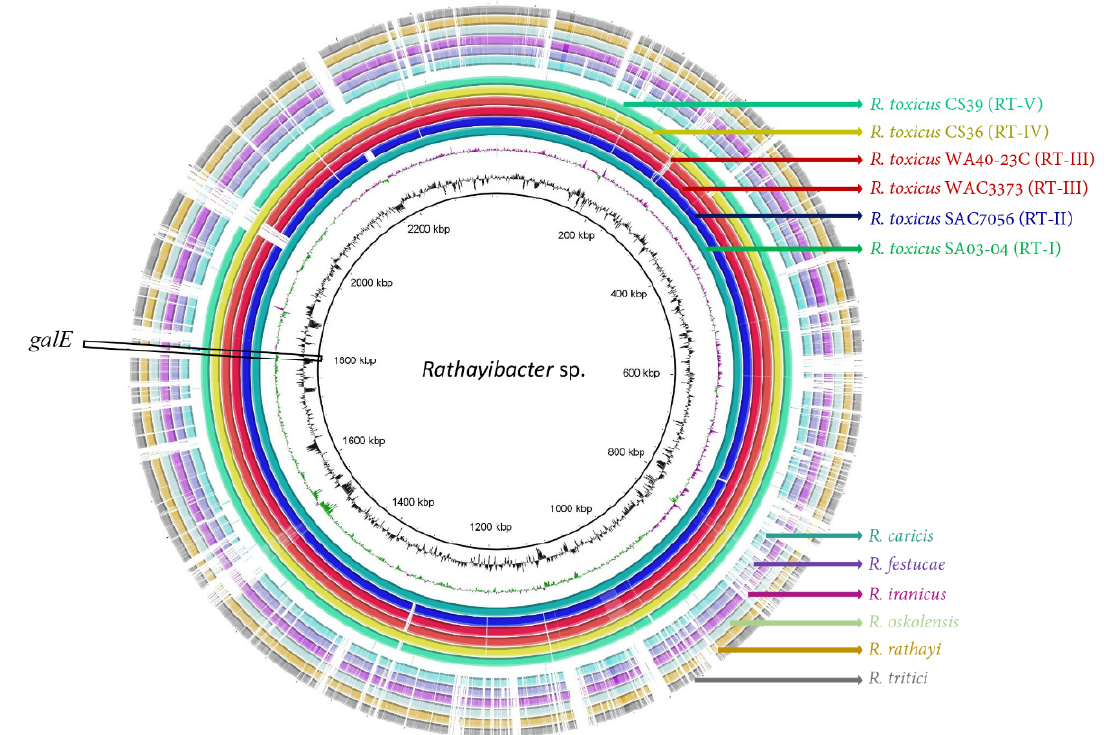
Figure 1. A ring image (BLAST Ring Image Generator) was used to locate the target UDP-glucose 4-epimerase ( galE ) gene region. Six genomes of Rathayibacter toxicus representing all known genetic populations RT-I to RT-V (respectively, RT-I: SA03-04, RT-II: SAC7056, RT-III: WAC3373 and WA40-23C, RT-IV: CS36, and RT-V: CS39) along with other Rathayibacter species, including R. tritici (CP015515) , R. rathayi (CP028129) , R. iranicus (CP028130) , R. caricis (GCF_003044275.1) , R. festucae (CP028137) , and R. oskolensis (GCF_900177245.1); from the center out: genome coordinates (kbp), GC content (black), GC skew (purple/green). The remaining rings show the BLASTn comparison of the 11 complete genomes as labelled. Rathayibacter toxicus population RT-I strain SA03-04 was used as the reference genome for comparison with the other genomes and to generate the ring image using BRIGS.